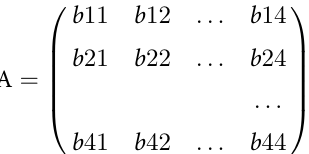
Table 2. Scale table. Scale Meaning 1 In the two-factor comparison, X i is as important as X j 3 In the two-factor comparison, X i is slightly more important than X j 5 In the two-factor comparison, X i is obviously more important than X j 7 In the two-factor comparison, X i is especially more important than X j 9 In the two-factor comparison, X i is extremely more important than X j 2,4,6,8 Median of the above two adjacent